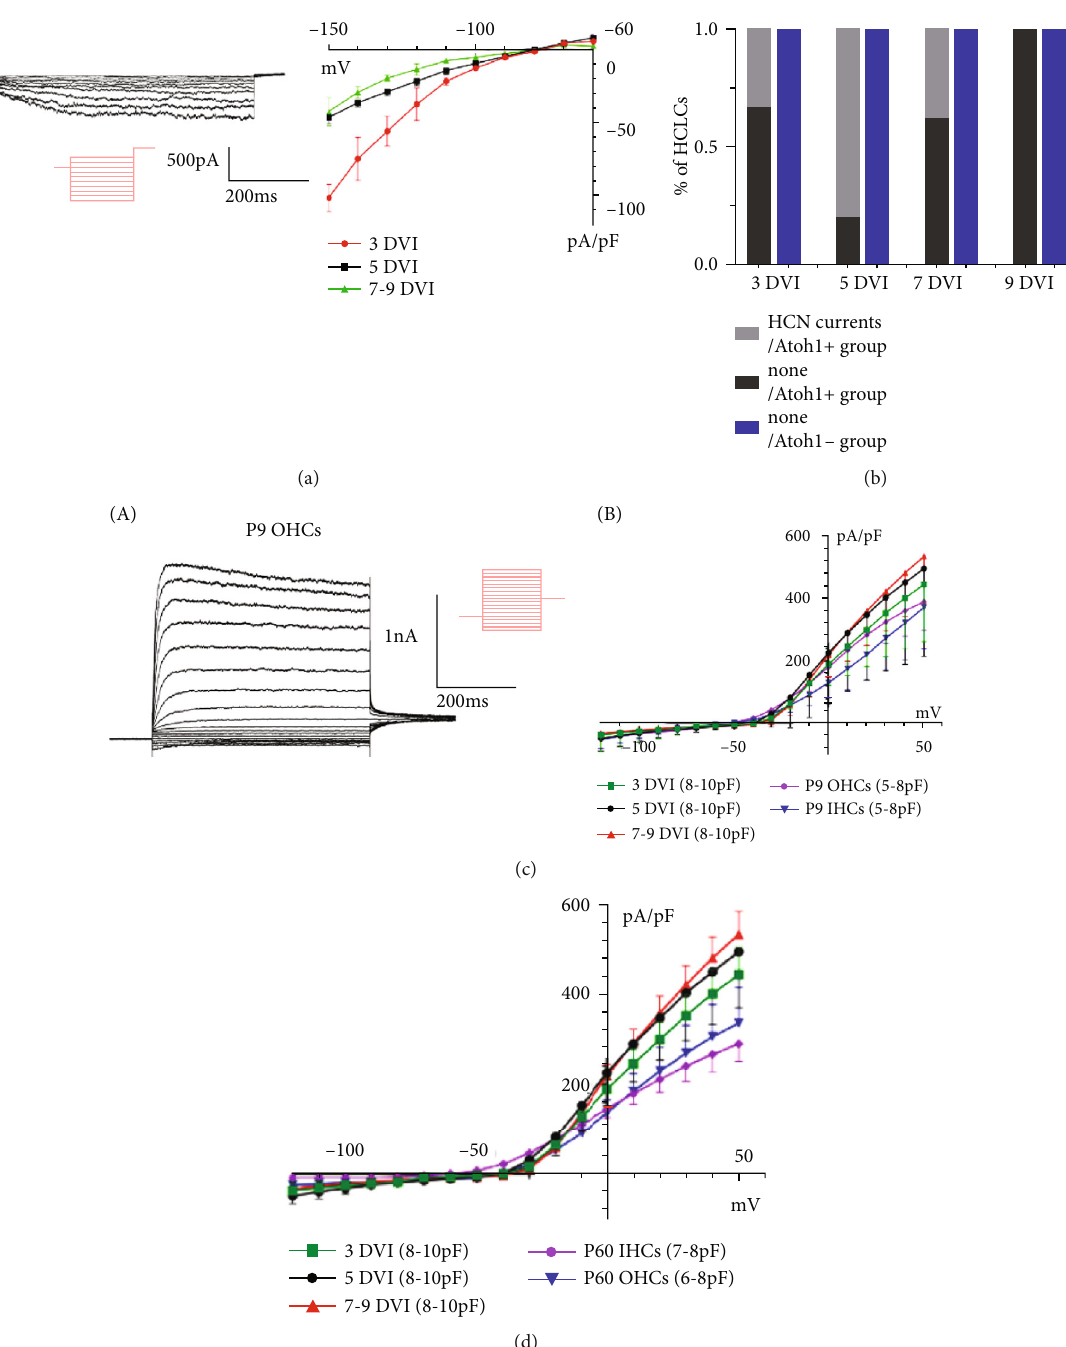
Figure 5: HCN currents of Atoh1-induced HCLCs and comparison of outward potassium currents of HCLCs from adult mice to normal HCs. (a) Representative HCN currents and I-V curves of HCLCs. The cell clamp was held at a holding potential of -70mv, and the voltage steps ranged from -150 to -60 mV in 10mV increments to evoke voltage-dependent currents. (b) Bar graph demonstrating the proportion of recorded HCN currents. (c) Representative outward K+ currents (A) recorded from P9 OHC. The I-V curves (B) show amplitudes of current density of OHCs and IHCs in P9 cochlea and HCLCs induced by Atoh1 in adult cochleae. (d) The I-V curves of OHCs and IHCs in P60 cochleae and Atoh1-induced HCLCs in adult